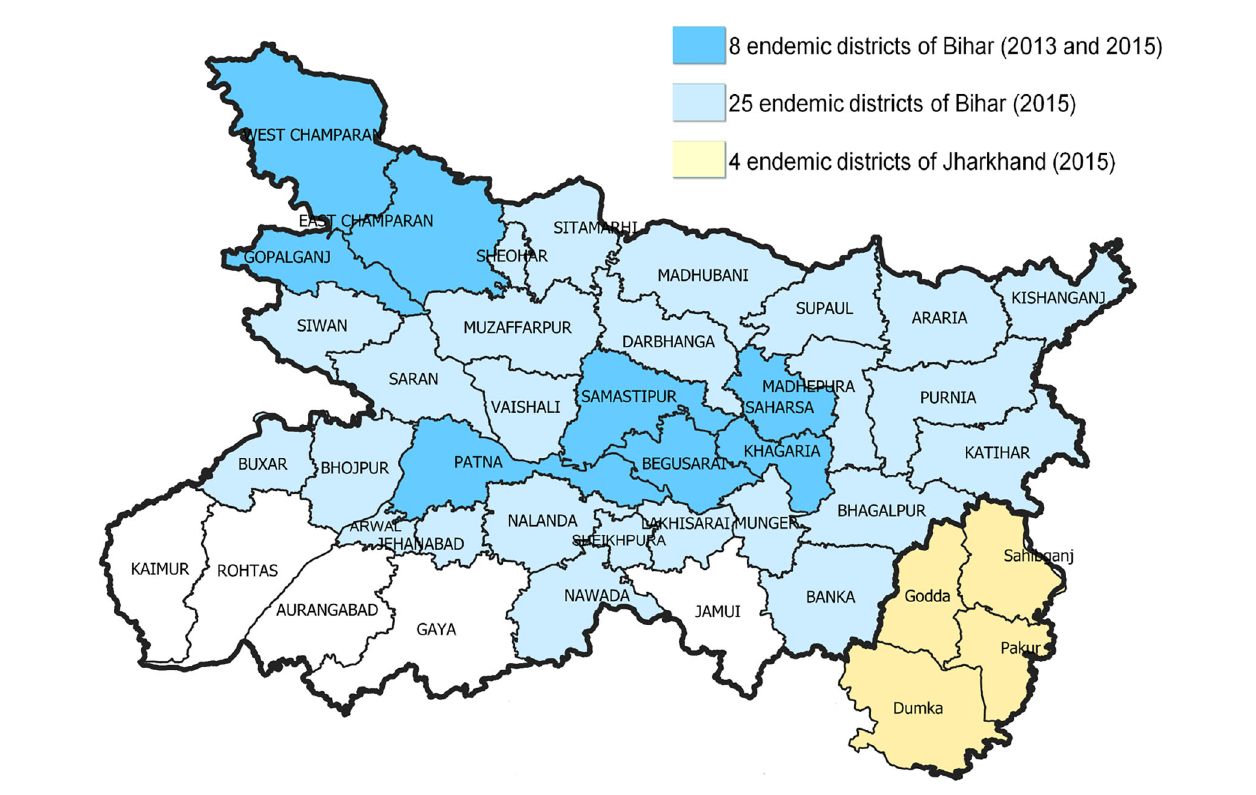
FIGURE 1 | Districts included in the 2013 and 2015 assessments of visceral leishmaniasis under-reporting. The 33 visceral leishmaniasis-endemic districts of Bihar are shown in blue, while the 4 endemic districts of Jharkhand are in yellow. Districts in darker blue were included in both